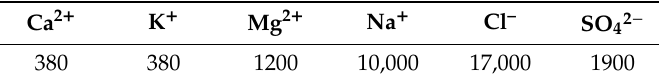
Table 2. Chemical analysis of seawater